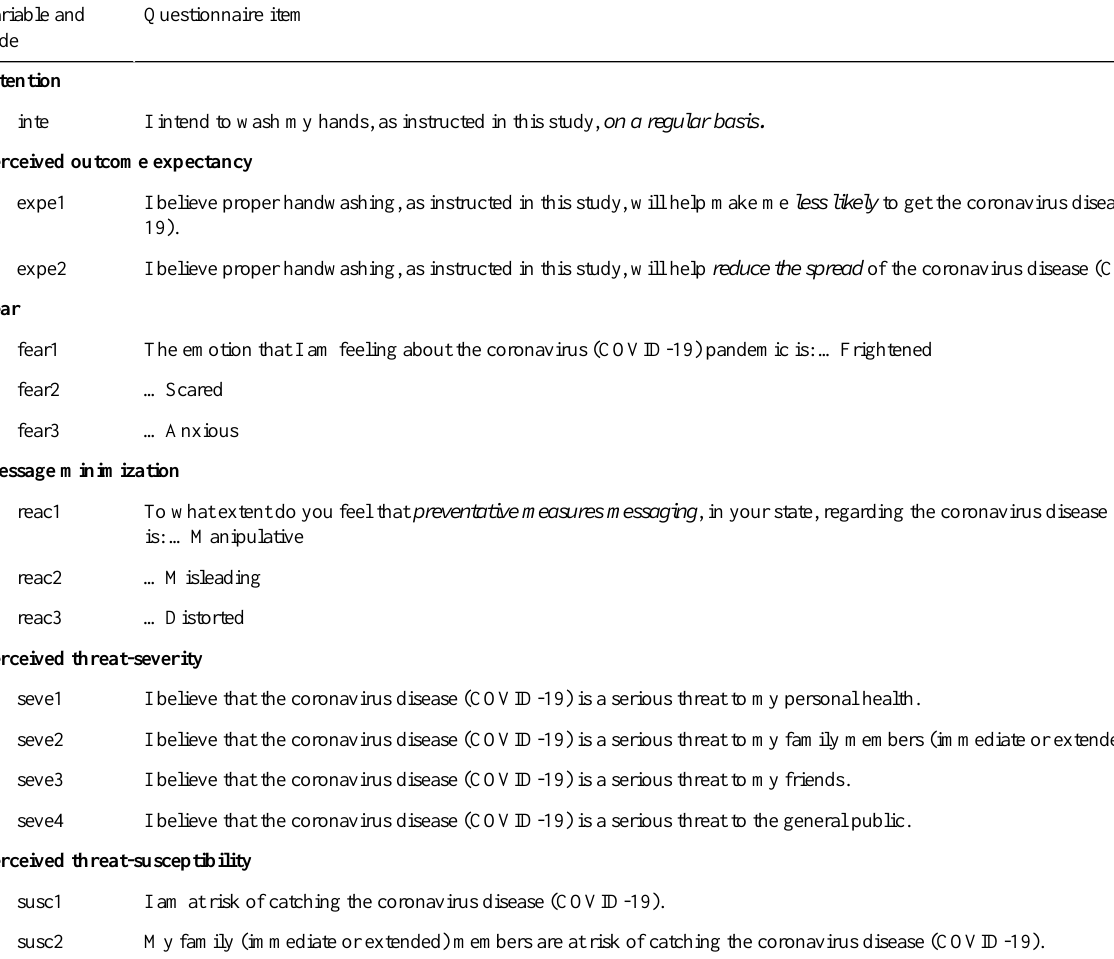
Table 1. Questionnaire items.